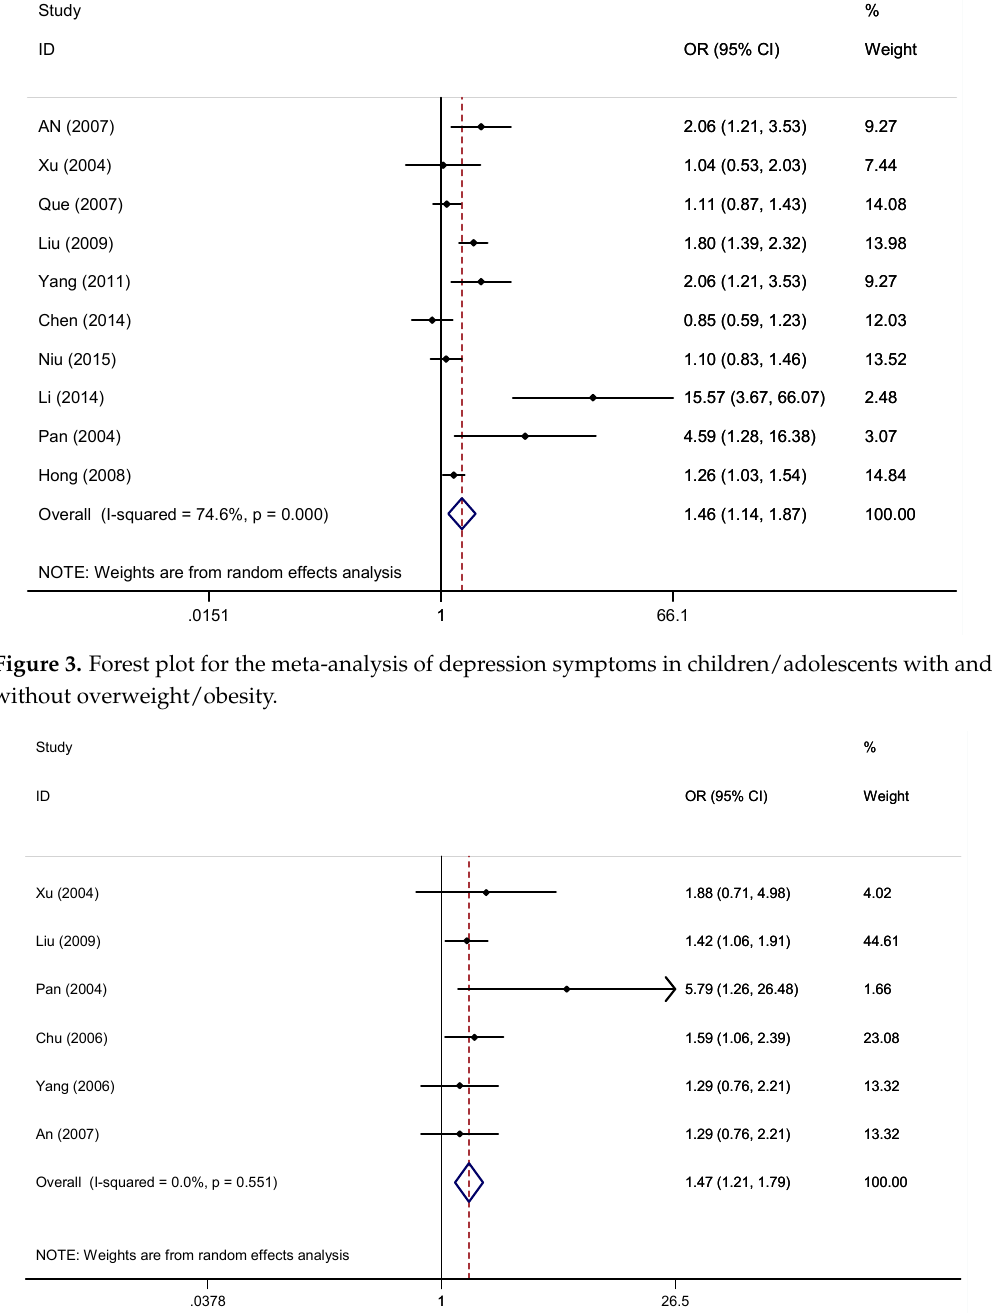
Figure 4. Forest plot for the meta-analysis of anxiety symptoms in children/adolescents with and without overweight/obesity.